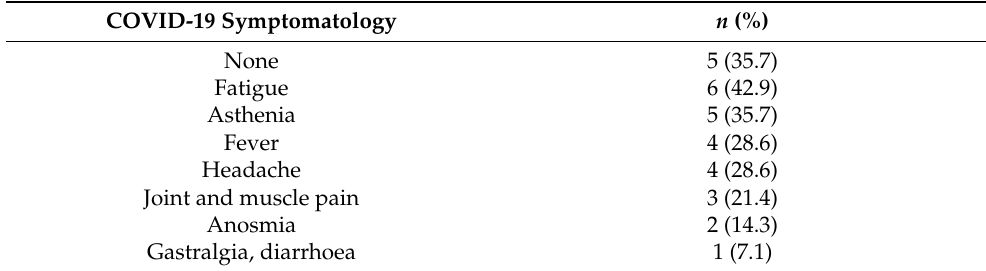
Table 2. Symptomatology associated with COVID-19 in professional football players with a certified infection of